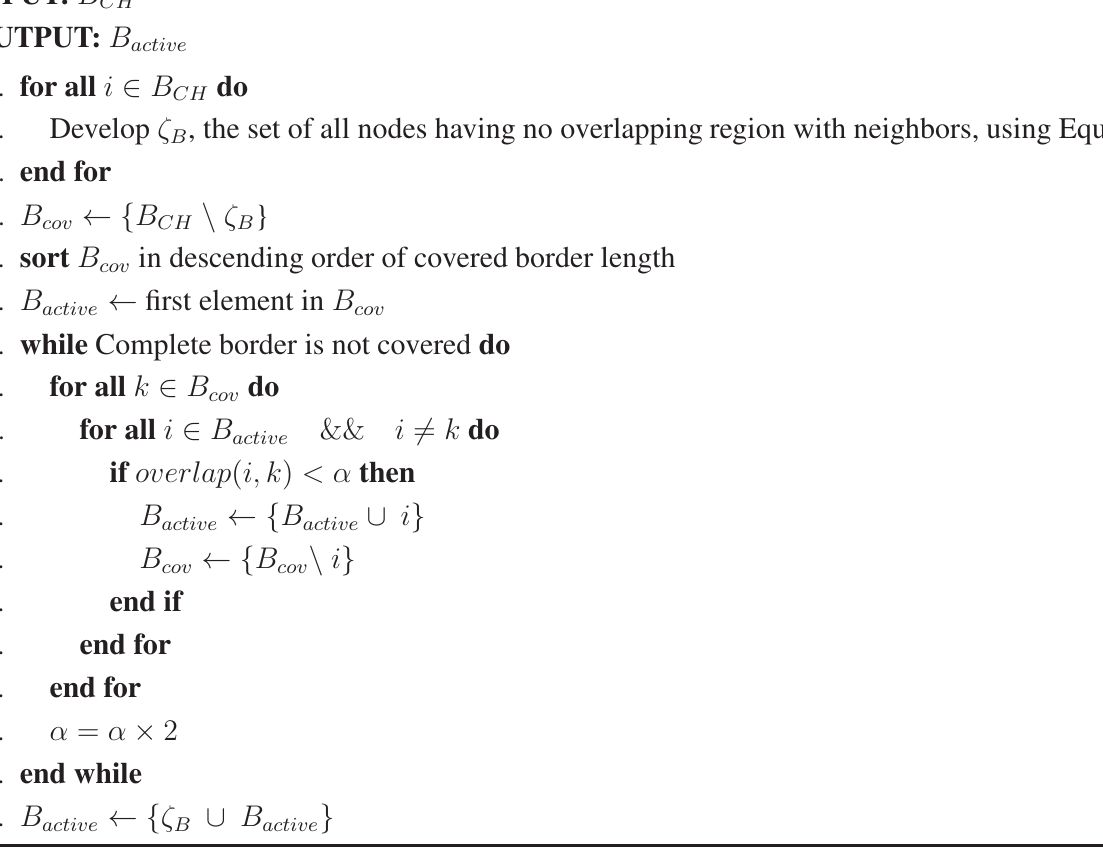
Algorithm 2 Border area coverage algorithm, at each cluster head